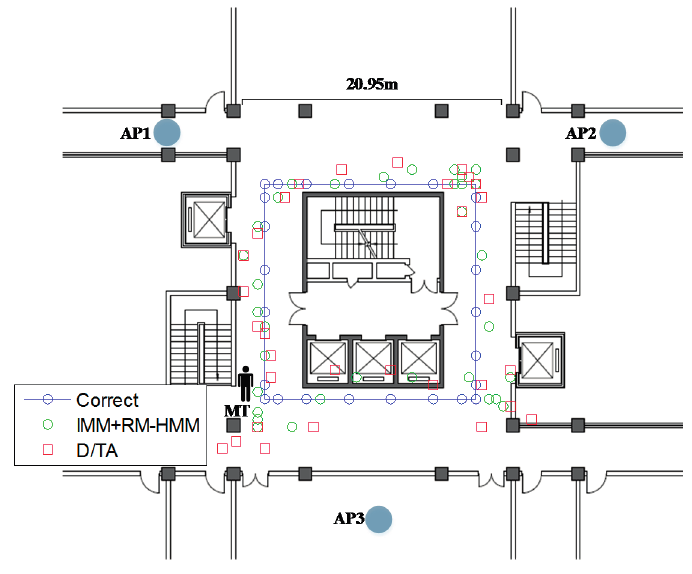
Figure 24. The trajectory of the MT in